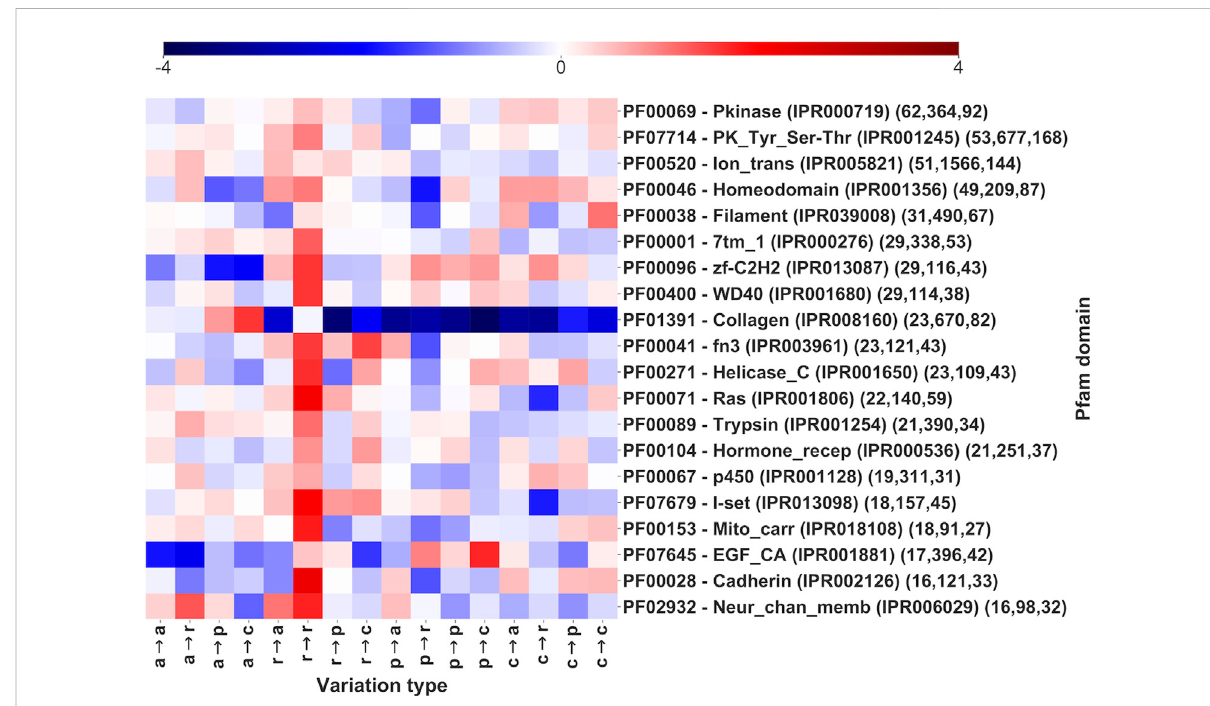
FIGURE 5 Log-oddscoresofvariationtypesinPfamentriessortedbynumberofgenescovered(the fi rst20,outof1,940Pfams,SupplementaryTableS3). Log-odds are computed with respect to the whole dataset LP/P background (Figure 3). For each Pfam, the corresponding InterPro accession is also included. Numbers within parentheses report the number of genes, variations, and diseases, respectively. The log-odd values are affected by a relative error lower than 5%, as estimated with a bootstrapping procedure. Statistical validation and resulting FDR-corrected p -values for each Pfam entry are reported in Supplementary Table